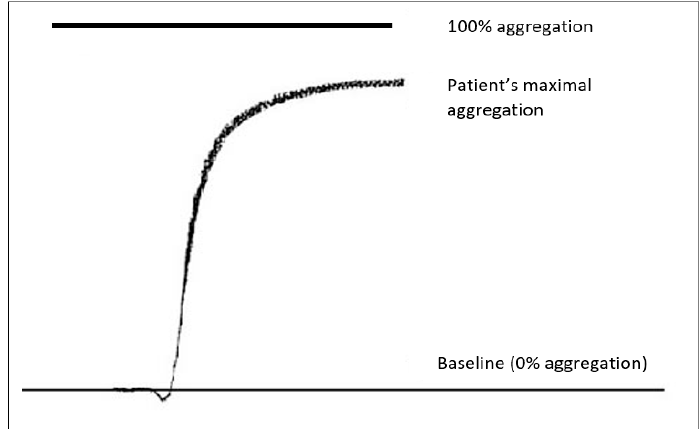
Figure 1. Graphical illustration of a normal LTA aggregation trace.